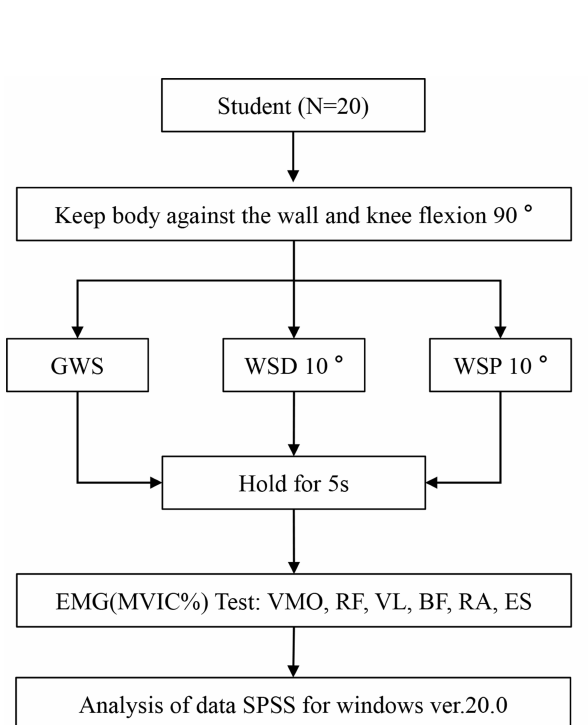
Fig. 1. Different wall squat exercises.